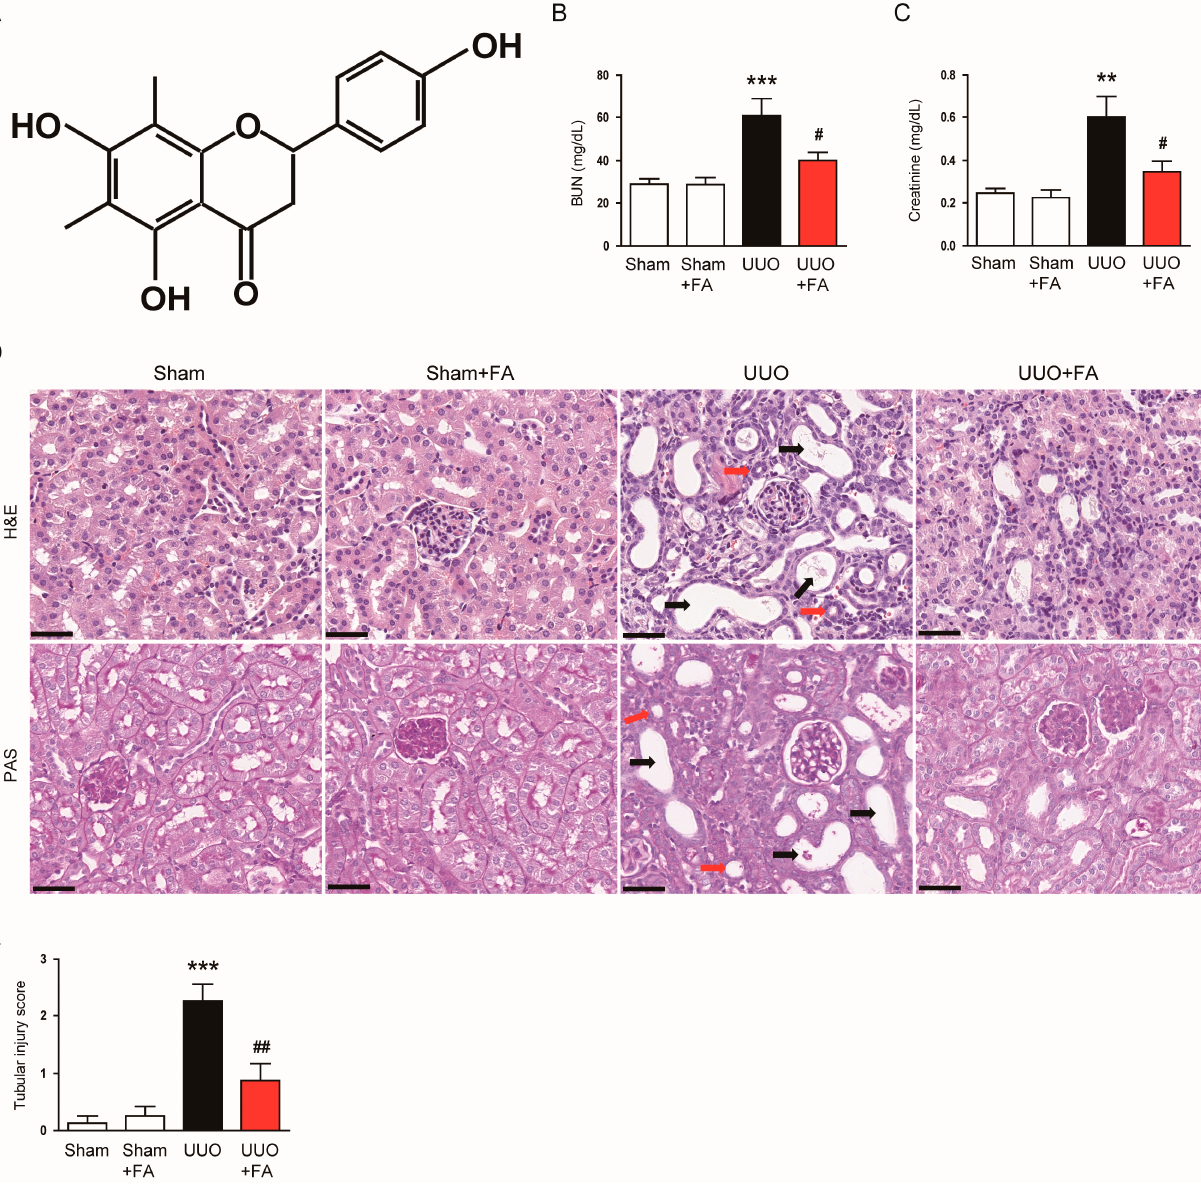
Figure 2. Effects of FA on renal function and histological morphology in UUO mice. ( A ) The chemical structure of FA. ( B ) BUN levels. ( C ) Serum creatinine levels. ( D ) H&E and PAS staining. Scale bar = 40 µ m. Red arrows indicate tubular atrophy. Black arrows indicate tubular dilatation. ( E ) Tubular injury score. ** p < 0.01 and *** p < 0.001 vs. Sham. # p < 0.05 and ## p < 0.01 vs. UUO. LTL is a specific marker for the proximal tubule brush border [28,29]. IF staining for